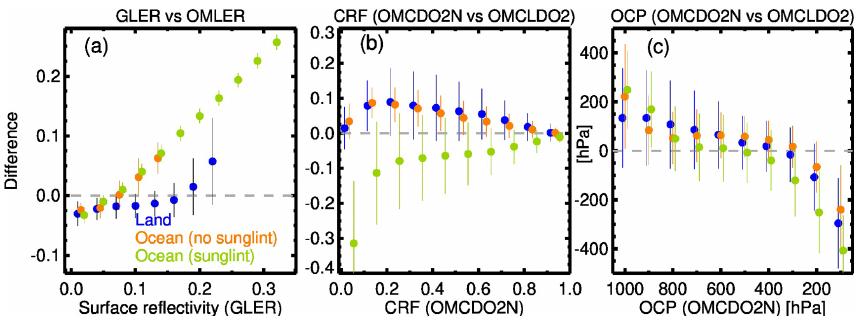
Figure 3. Differences (V4.0–V3.1) in (a) surface reflectivity, (b) cloud radiance fraction, and (c) cloud optical centroid pressure for 20 March 2005, as used in the V3.1 and V4.0 algorithms and binned by the values of corresponding parameters from V4.0. Data are separated for land (blue) and ocean surfaces, as well as by sun-glint (green) and non-sun-glint (orange) geometry over ocean. The vertical bars represent the standard deviation for each bin of those parameters.